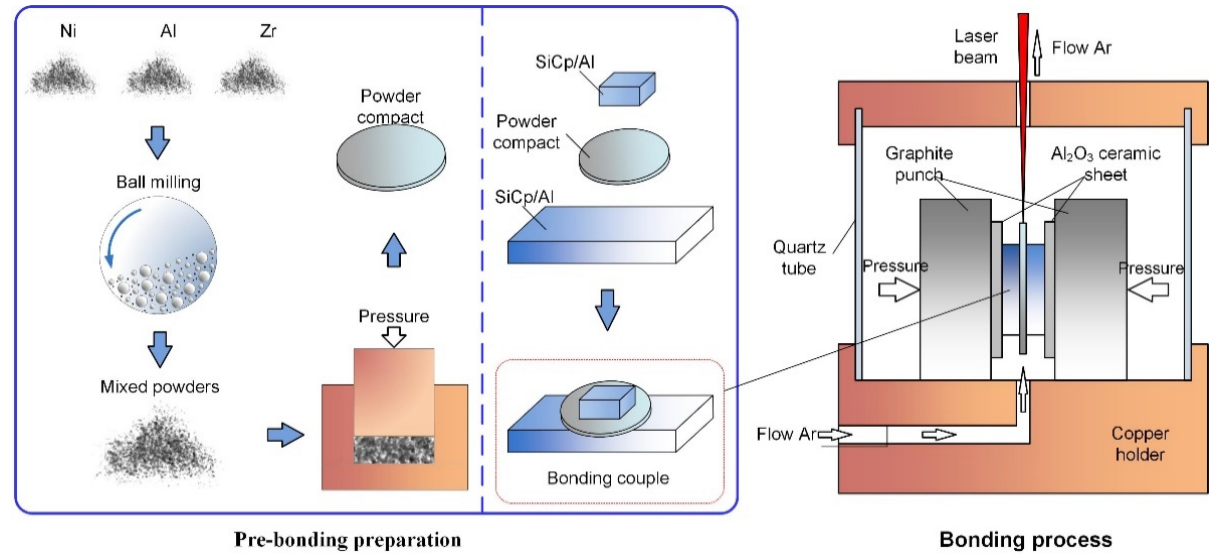
Figure 2. Schematic diagram of laser-induced exothermic bonding.